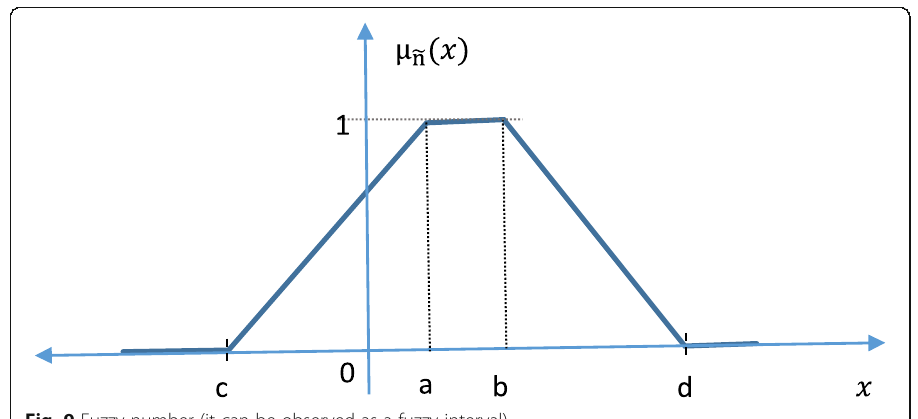
Fig. 9 Fuzzy number (it can be observed as a fuzzy